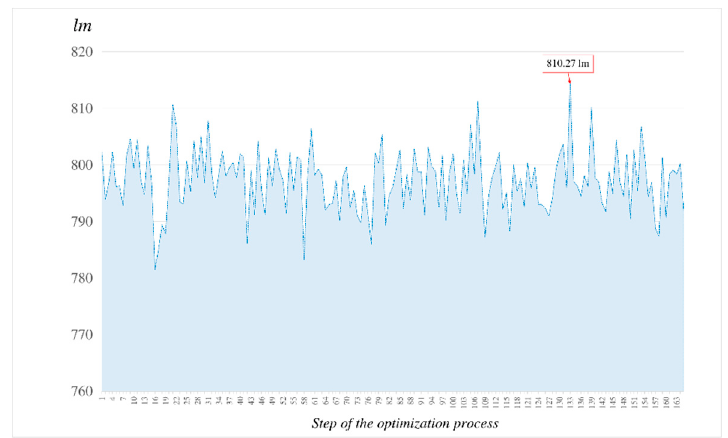
Figure 14. The recorded value for the intensity sensor versus running cycles.